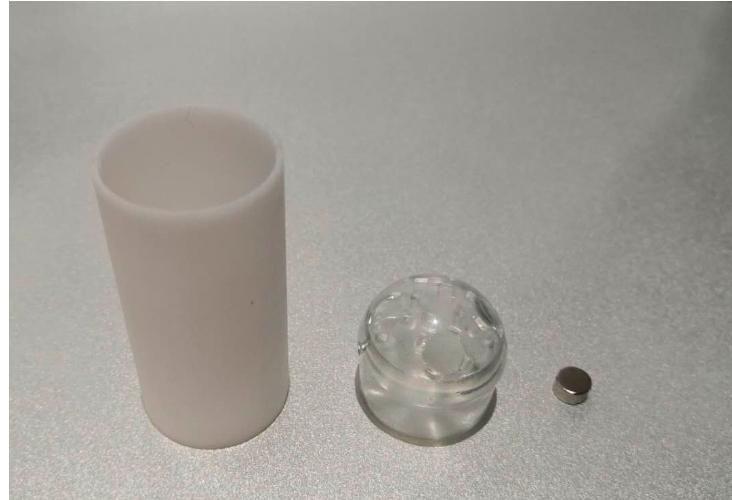
Figure 11. The structure of the rotor used in experiment. ( left ) The cylindrical shell of the rotor. ( middle ) The hemispherical head of the rotor. ( right ) One of five permanent magnets installed on the hemispherical head.